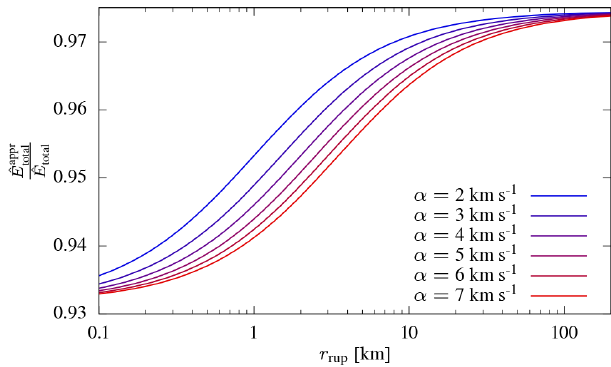
Figure B1. Ratio between the approximate and exact energy es- timates for different P wave velocities in the medium. The exact estimate assumes that P and S waves arrive at different velocities at the recording site, while the approximate estimate assumes that all waves arrive with shear wave velocity at the site. This approxima- tion introduces only a minor underestimation, since most radiated energy is released as S waves. The distance variation arises from the different distance and velocity dependencies of the intermediate- field terms and the far-field